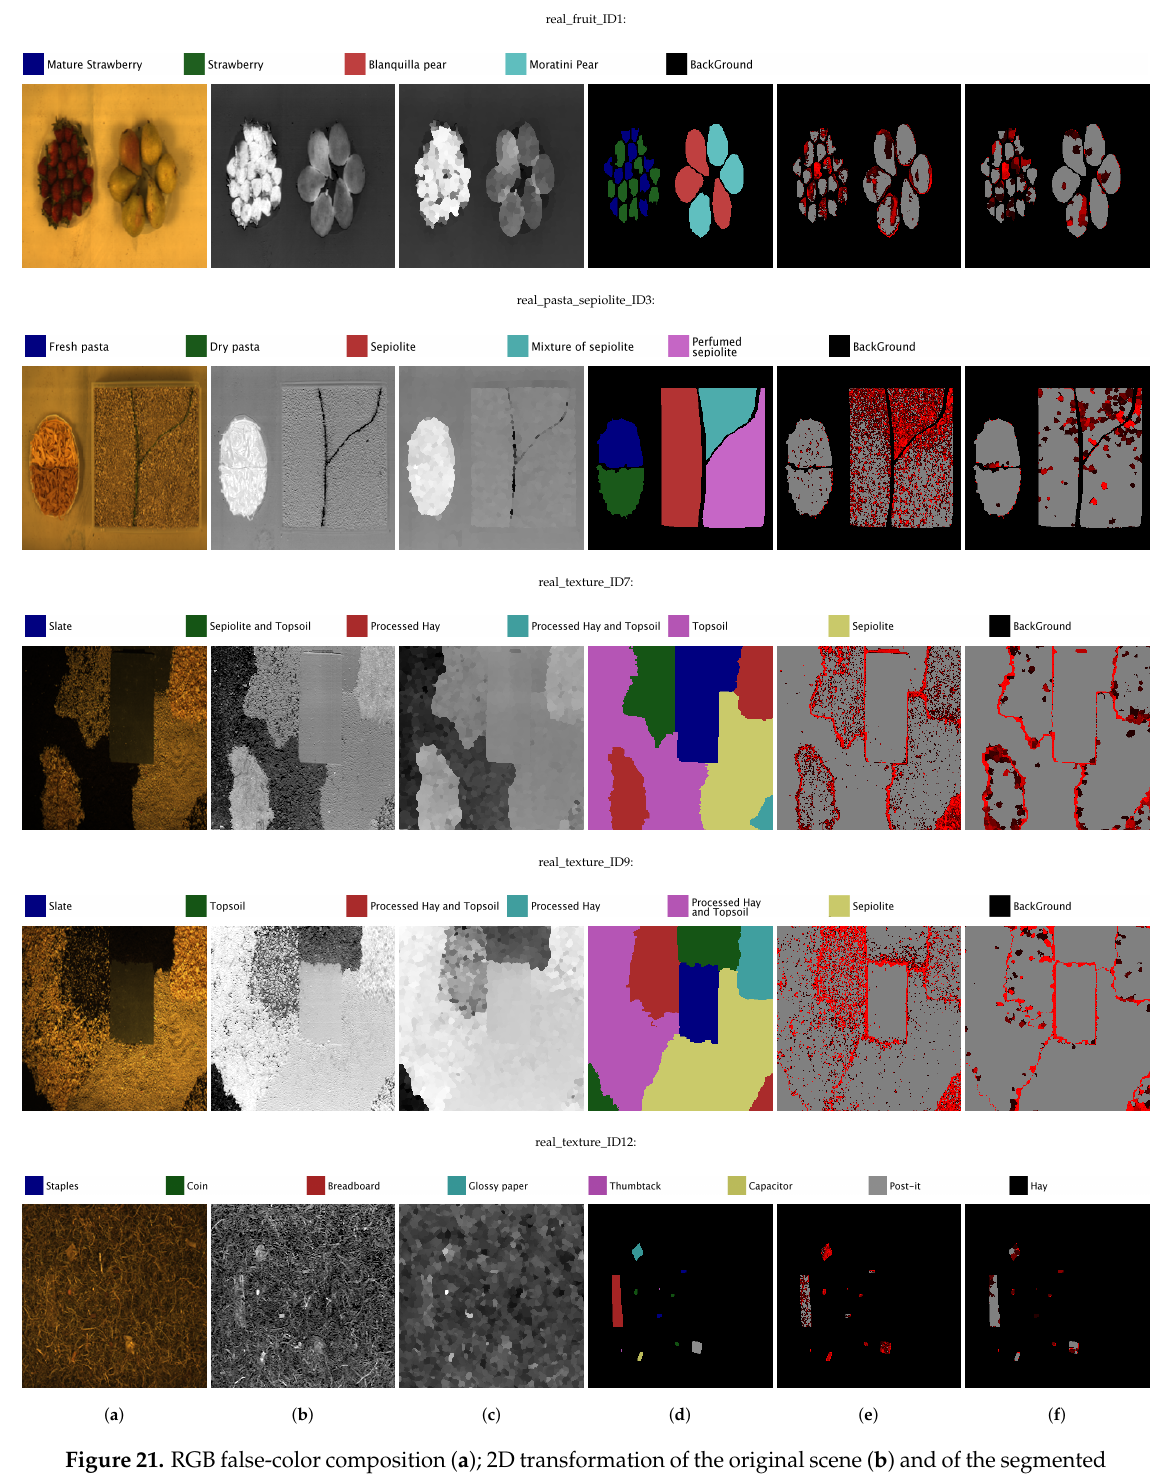
Figure 21. RGB false-color composition ( a ); 2D transformation of the original scene ( b ) and of the segmented image provided by ECAS-II ( c ); ground truth ( d ); SVM based pixel classification applied to the original scene ( e ); and to the segmented image provided by ECAS-II ( f ) showing only the labeled areas and marking misclassified pixels with red dots (a brighter red pixel means that it has been misclassified more times after applying the SVM algorithm 10